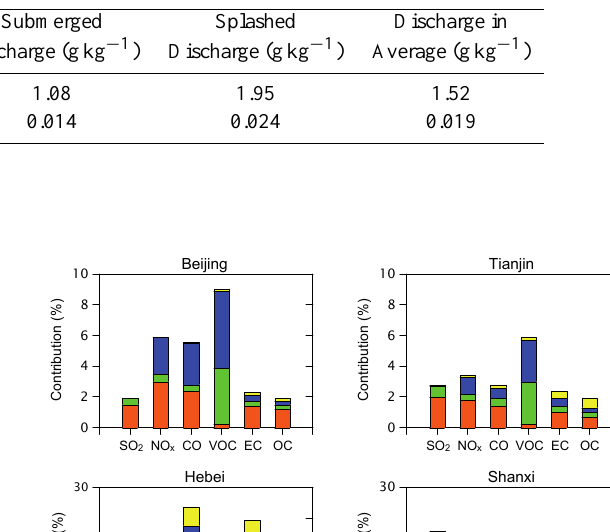
Sources are from 9 Sun and Wang (1997) and 21 Van Aardenne (2002).